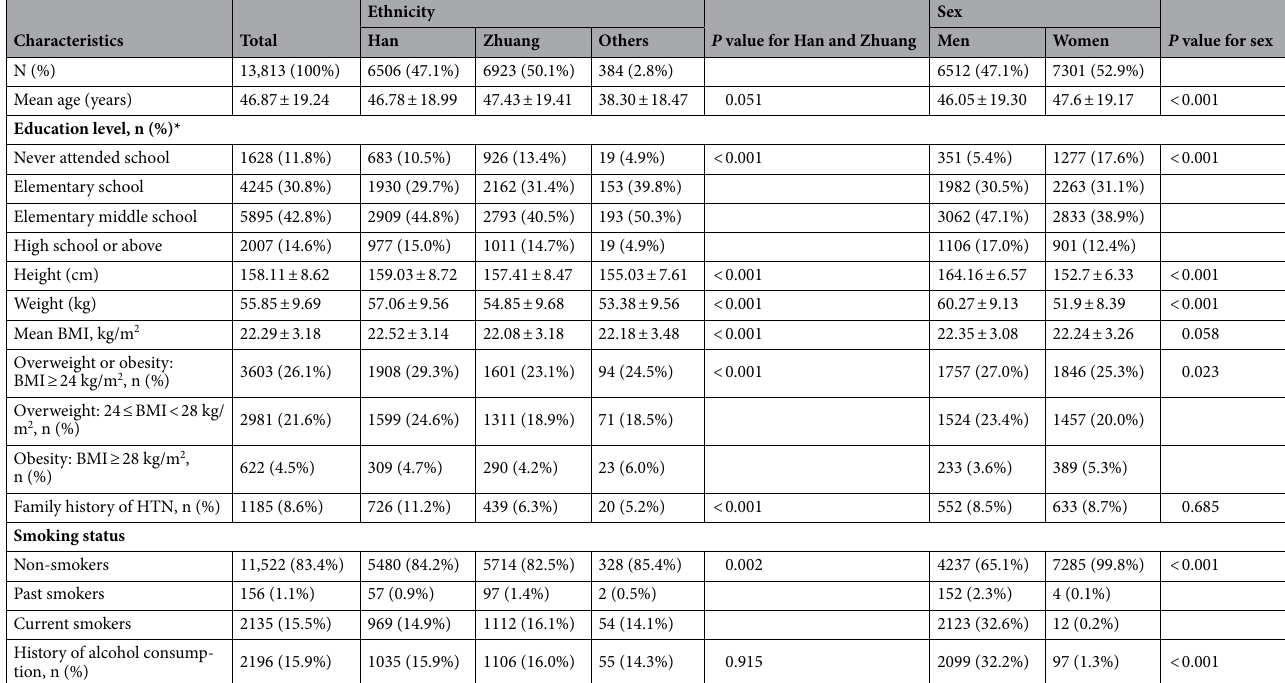
Table 1. Characteristics of study group by sex and ethnicity. HTN hypertension, BMI Body Mass Index. Data are presented as n (%) or mean ± SD. *Missing 38